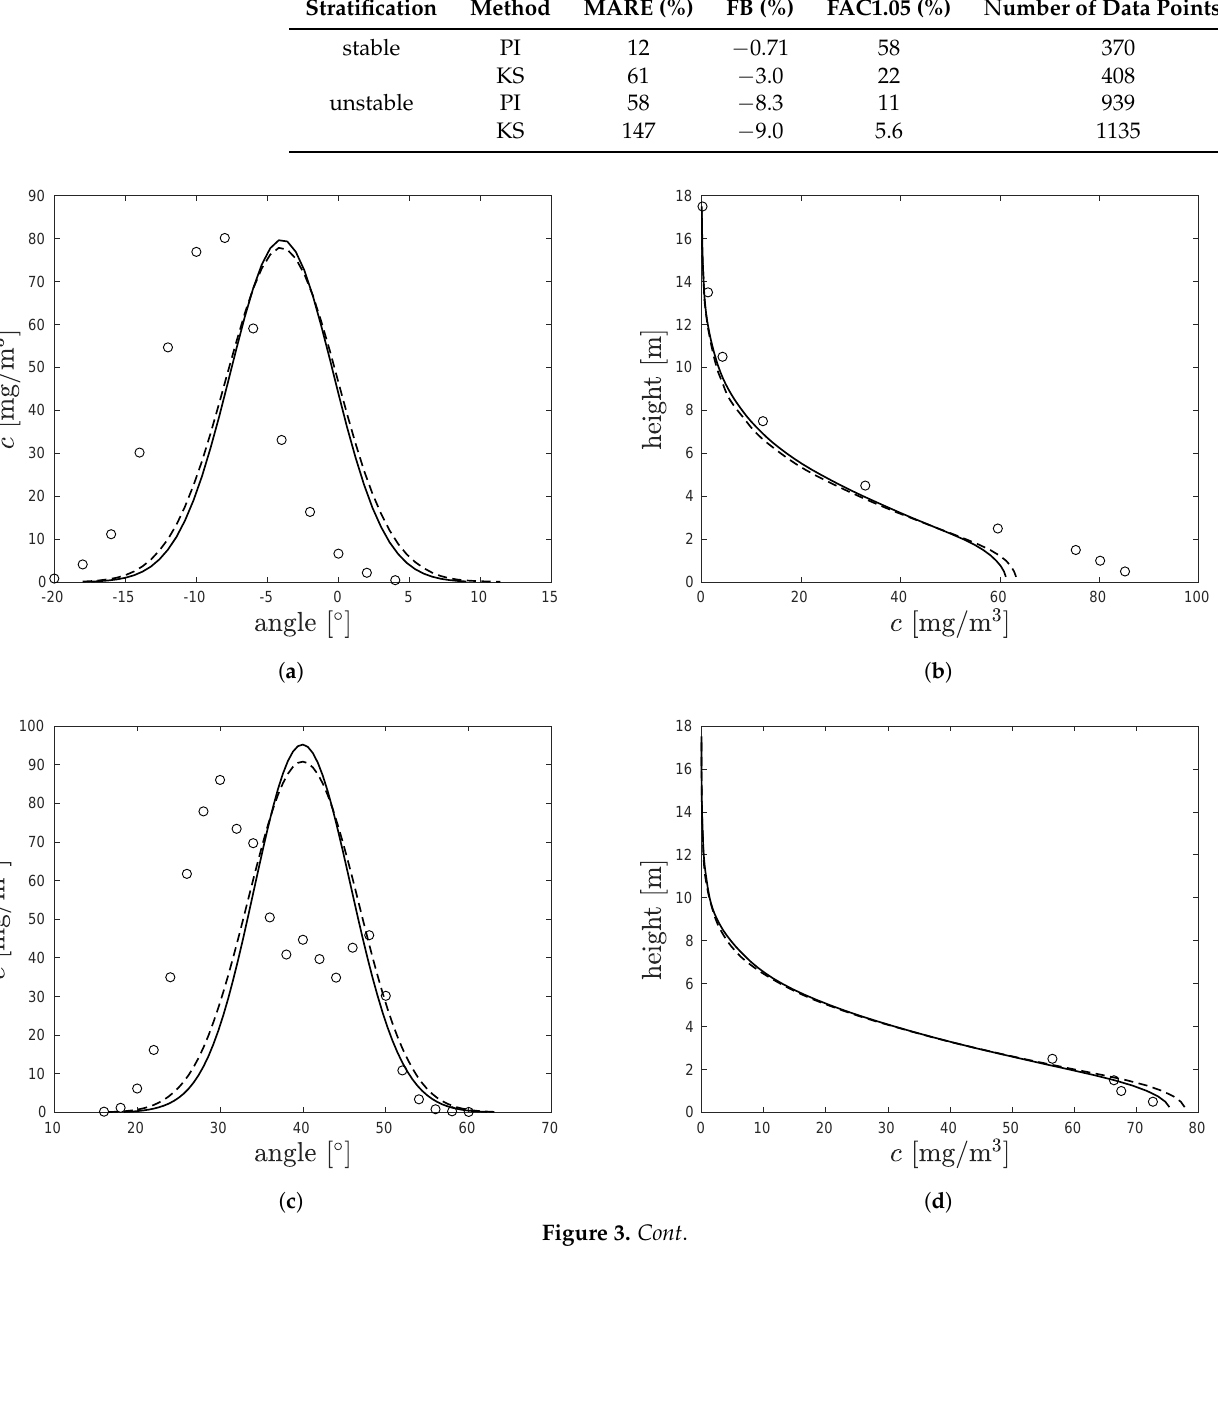
Table 4. Convergence test, comparison of (cid:98) c ( ∆ t ∗ /2,50 n p ) and (cid:98) c ( ∆ t ∗ , n p ) . Stable: experiments 22, 29 and 40 with n p = 1000 particles per release time and ∆ t ∗ = 0.05. Unstable: experiments 15, 34 and 61 with n p = 1000 particles per release time and ∆ t ∗ = 0.01.